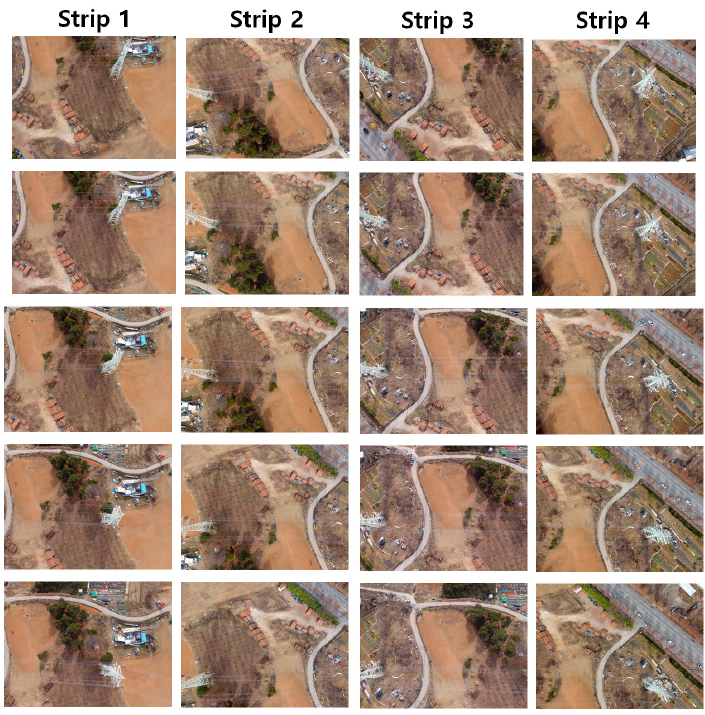
Figure 7. The four acquired strips of aerial images.